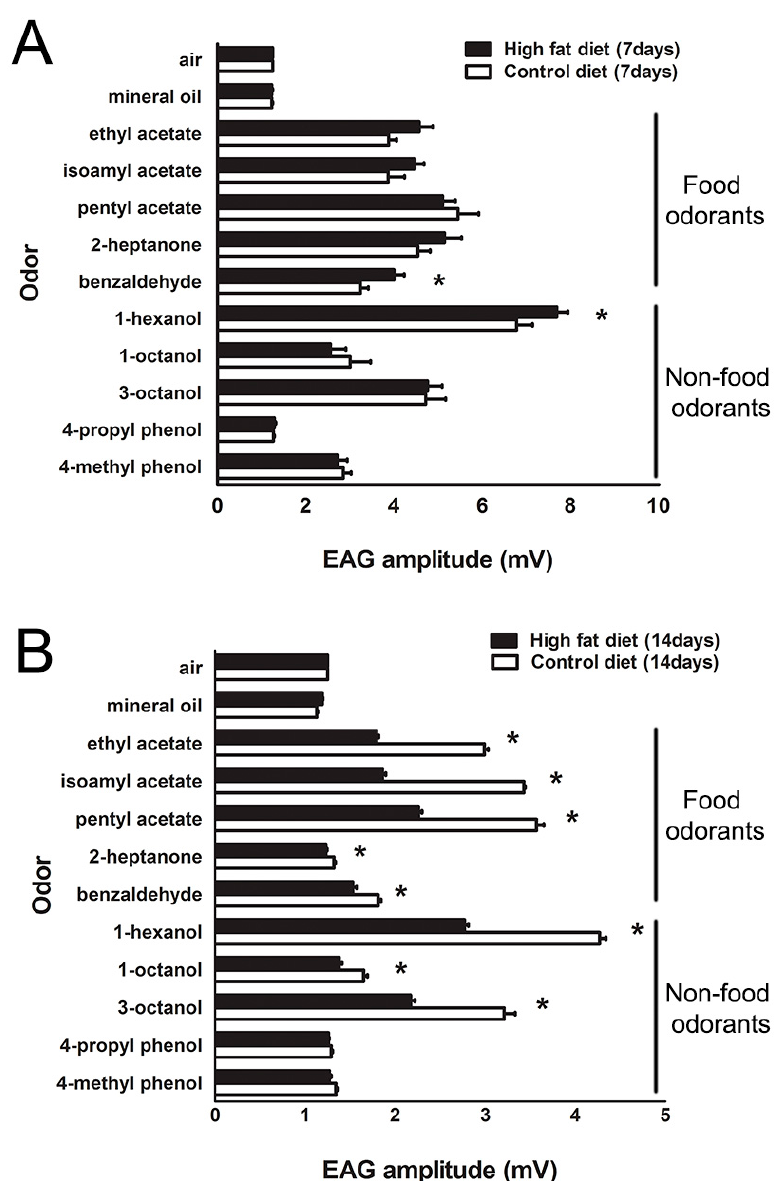
Figure 2. Olfactory responses of wild type Canton-S flies fed with control diet and HFD for seven days and 14 days. ( A ) Flies fed with HFD for seven days showed a reduction of olfactory responses to several odors. ( n = 15 flies, * p < 0.05). Error bars represent SEM. ( B ) Diet treatment for 14 days demonstrated that olfactory sensitivity was mostly decreased to most odorants. Flies fed with HFD for 14 days showed a decline of olfactory responses to several odors, such as ethyl acetate, isoamyl acetate, pentyl acetate, 1-hexanol, and 3-octanol. ( n = 15 flies, * p < 0.05). Error bars represent SEM.